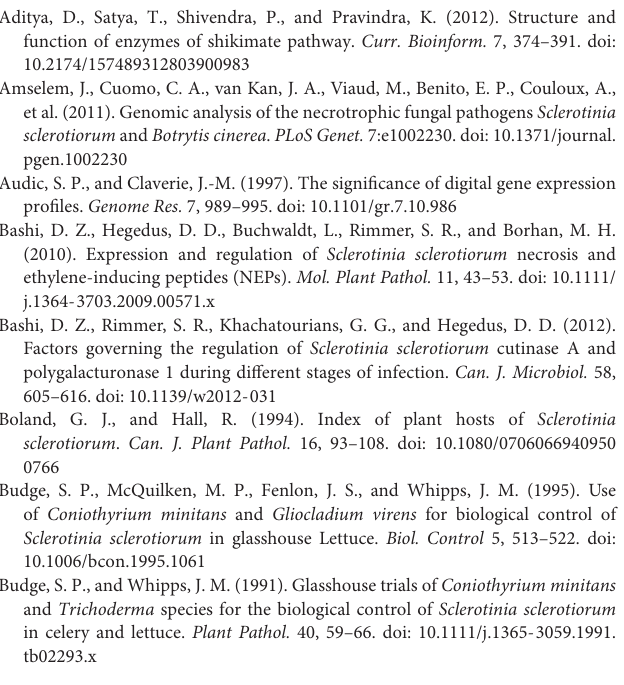
TABLE S4 | The significantly enriched KEGG pathway of the DEGs of S. sclerotiorum during the early mycoparasitism stages ( p ≤ 0.05). The KEGG